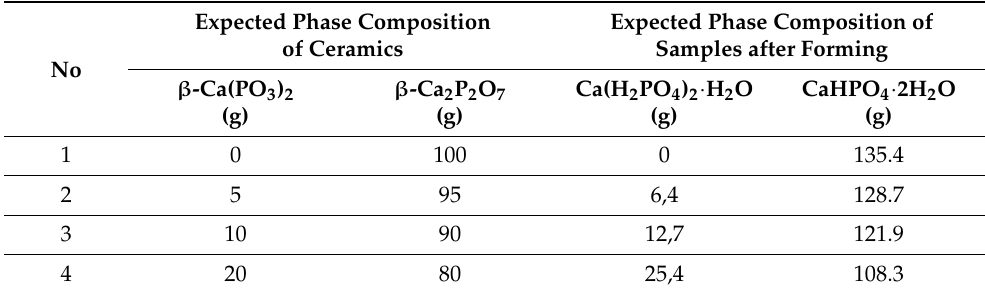
Table 1. The specified phase composition of the ceramic materials and corresponding composition of the samples after